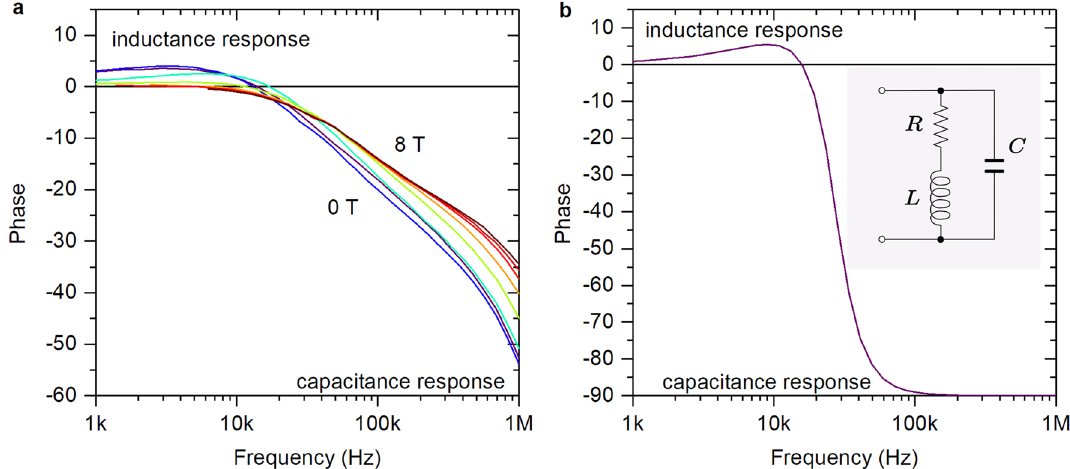
Figure 3. Frequency dependence of the complex impedance phase of the TiN film. ( a ) Results of the measurements performed between gold electrodes with the distance of 50 µ m at T = 35 mK. We observed evolution from inductance to capacitance response with frequency increasing. ( b ) Typical frequency dependence of the ( RL ) (cid:31) C circuit (see insert).